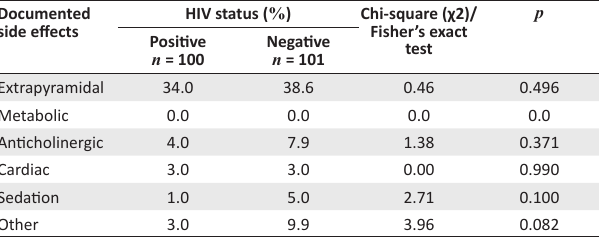
TABLE 4: Human immunodeficiency virus status and side effects of antipsychotics ( n = 201).